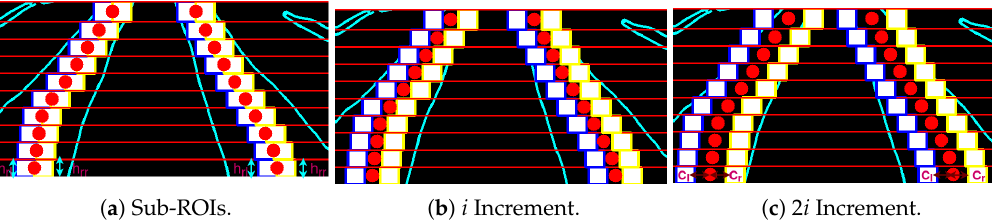
Figure 7. The proposed Adaptive Multi-ROI methodology to adapt to the varying crop row widths using incremental search along horizontal